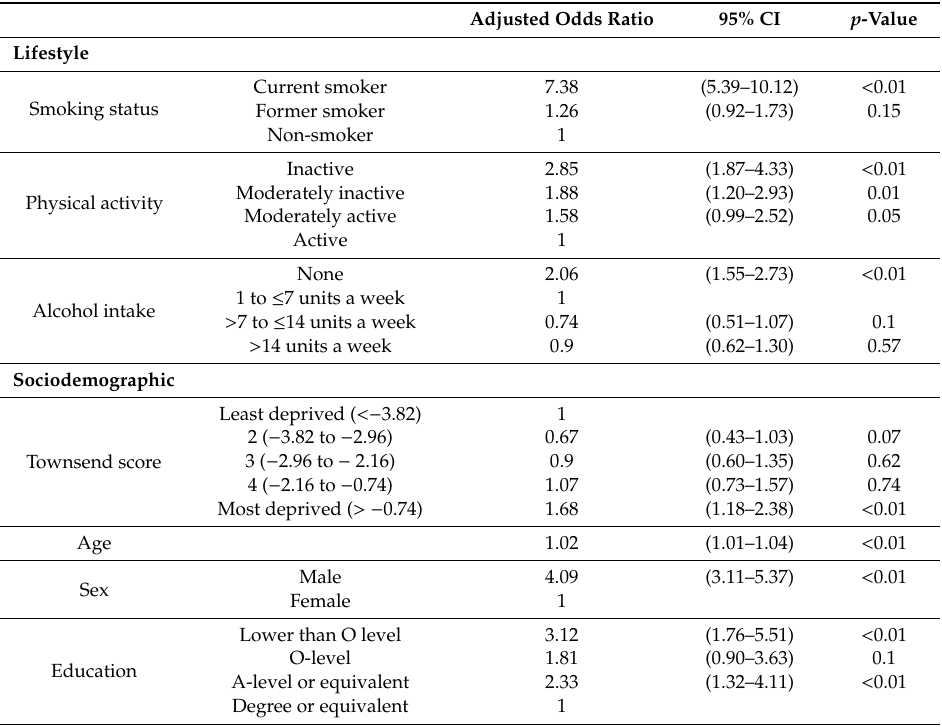
Table 2. Risk factors for vitamin C deficiency in EPIC-Norfolk cohort